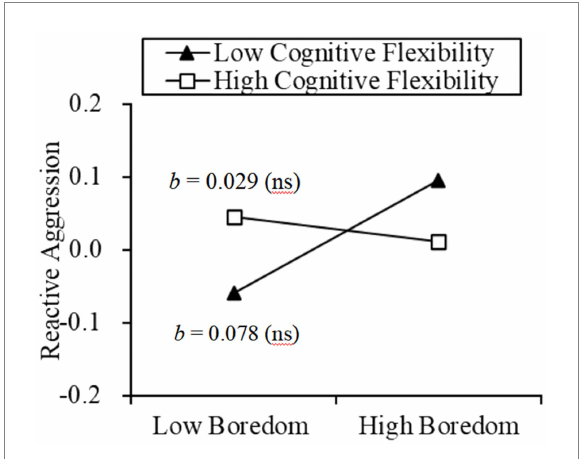
FIGURE 4 Moderation effect of cognitive flexibility on the relationship between boredom and reactive